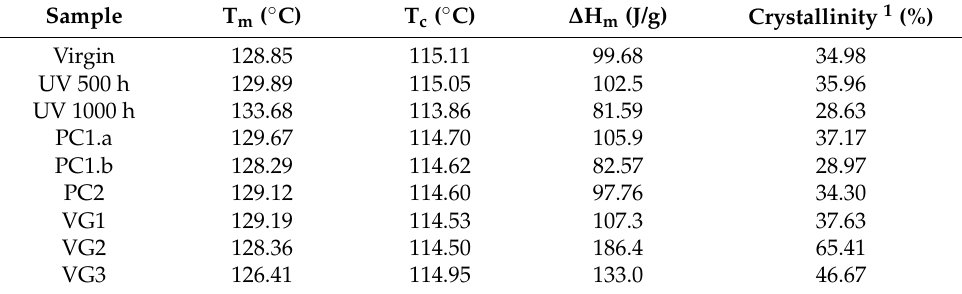
Table 6. Thermal properties of the central part (CP) samples of the